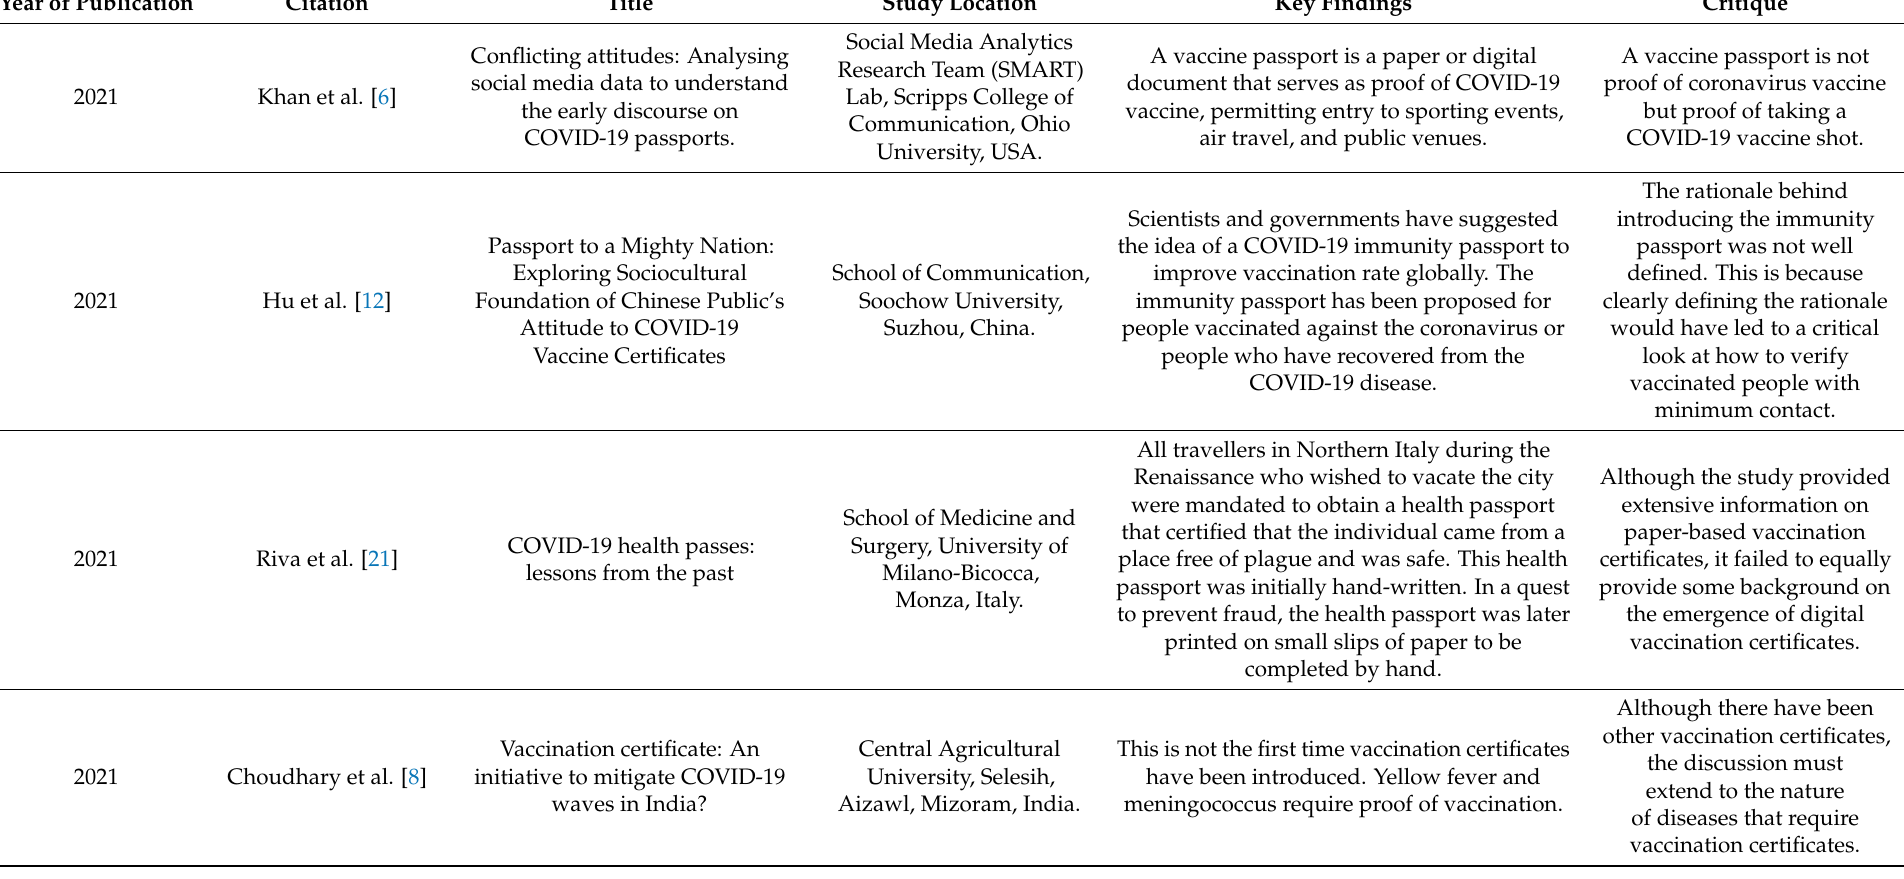
Table 6. History of vaccination